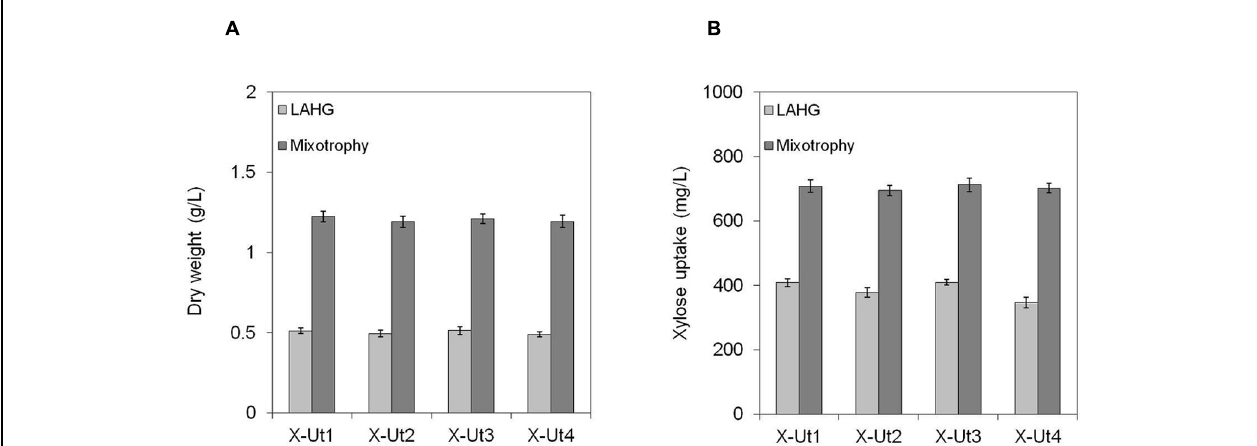
FIGURE 9 | Growth and xylose consumption in the presence of 5 mM xylose and glucose. Synechocystis strains X-Ut1, X-Ut2, X-Ut3, and X-Ut4 were grown in the presence of 5 mM (750 mg/L) xylose and 5 mM (900.8 mg/L) glucose. (A) Dry biomass values estimated at the end of the seventh day for the LAHG condition and at the end of the third day for mixotrophy. (B) Xylose consumption at the end of the seventh day for the LAHG condition and at the end of the third day for mixotrophy, determined by the measurement of residual xylose in the cell-free medium. Data were collected from three biological replicates and presented as means ± standard deviations.